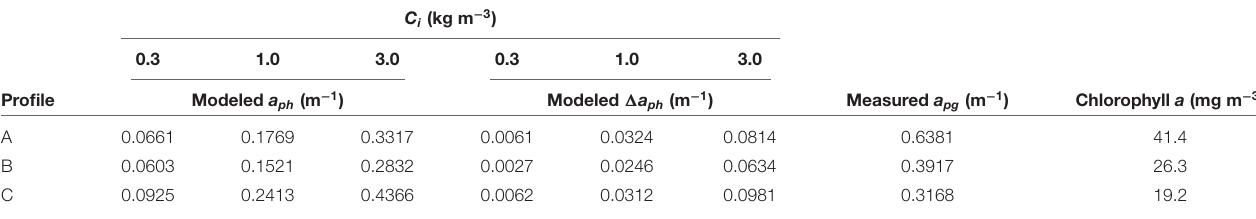
TABLE 1 | a ph and 1 a ph (m − 1 ) at 676 nm modeled for colonial diatoms using three C i values (0.3, 1.0, and 3.0 kg m − 3